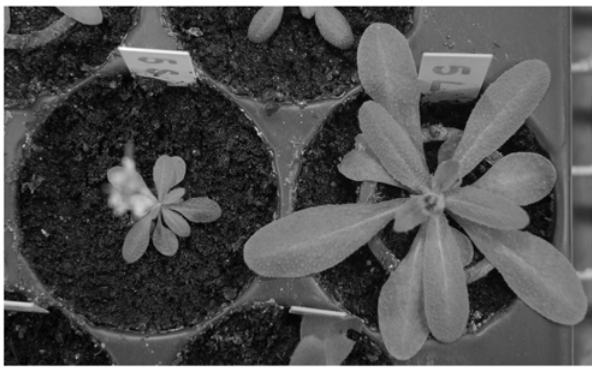
Figure 1. Plants grown in 10 and 40 mm diameter cylinders inserted into cells within a single flat. The two plants shown are genetically identical (from the same line). Note that the surface area available to growing rosettes is exactly the same for both